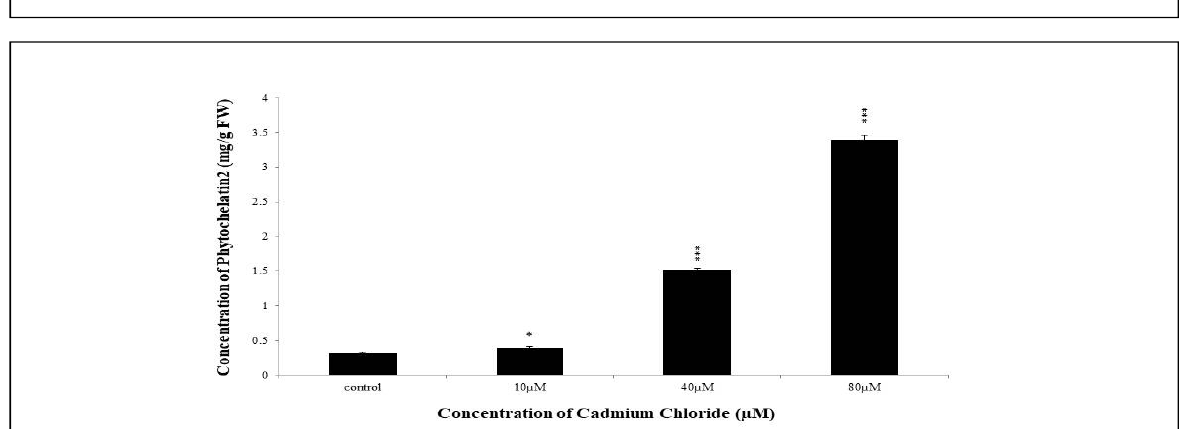
concentrations (mg/g fresh weight) obtained by RP-HPLC analysis 2 2